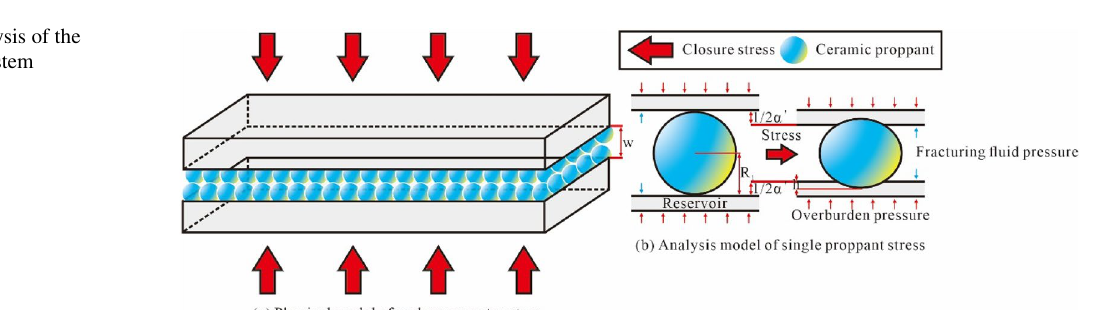
Fig. 4 Force analysis of the rock–proppant